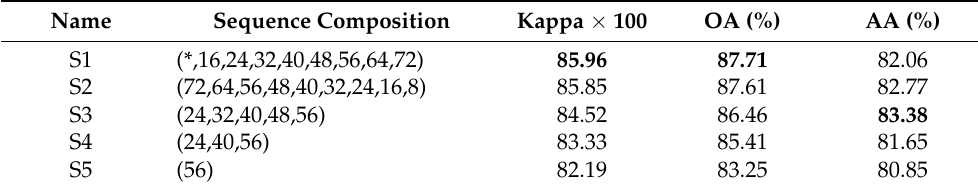
Table 5. The tests with different sequence